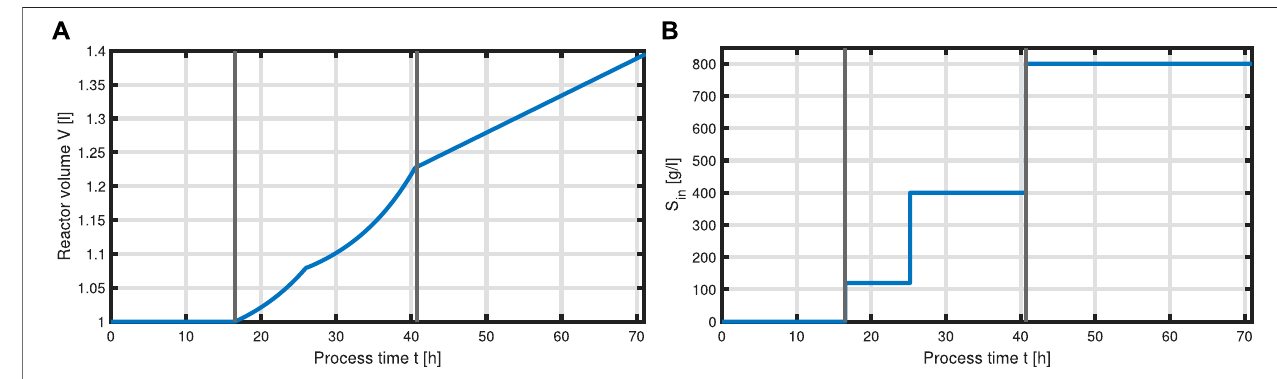
FIGURE7| Comparison ofthesimulatedquantities (solidblueline)againsttheexperimentaldata(points)oftheL-phenylalanineproduction processupto t =71 h. Timecourseofthefollowingconcentrations:glycerol S (A) ,biomass X ,L-tyrosine A (B) ,L-phenylalanine F (C), andacetate O asrepresentativeoftheby-products ofthe process (D) . The data points of L-tyrosine, which are negative due to insuf fi cient measurement sensitivity, are set to zero.